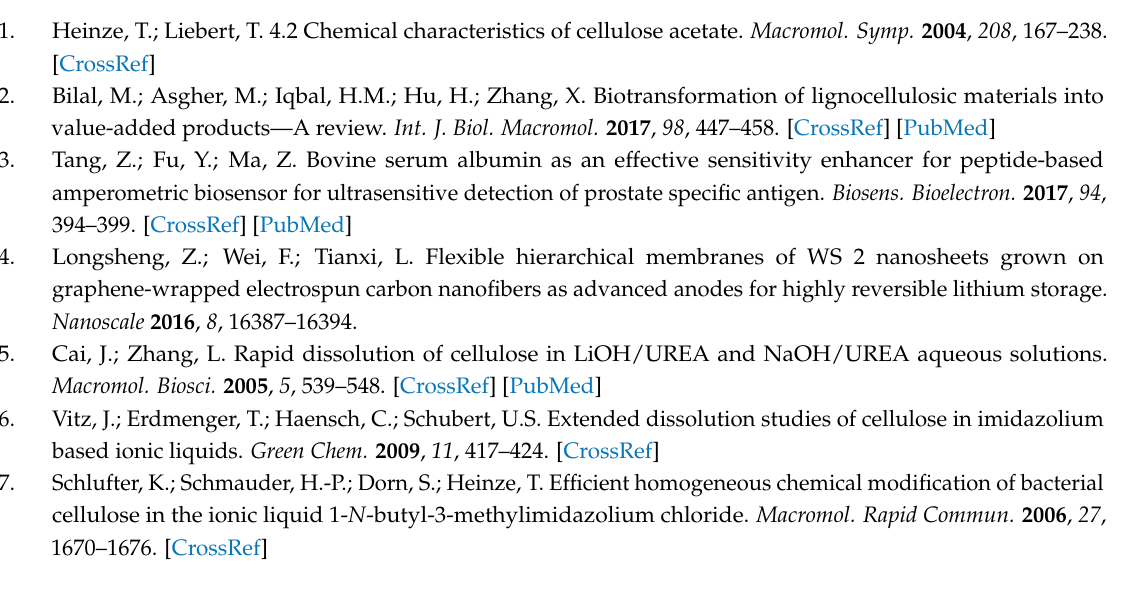
Figure S2: 1 H- 1 H COSY ( A ) and HSQC spectra ( B ) of the CA sample with DS of 2.75. Acknowledgments: This work was financially supported by the National Program for Support of Top-notch Young